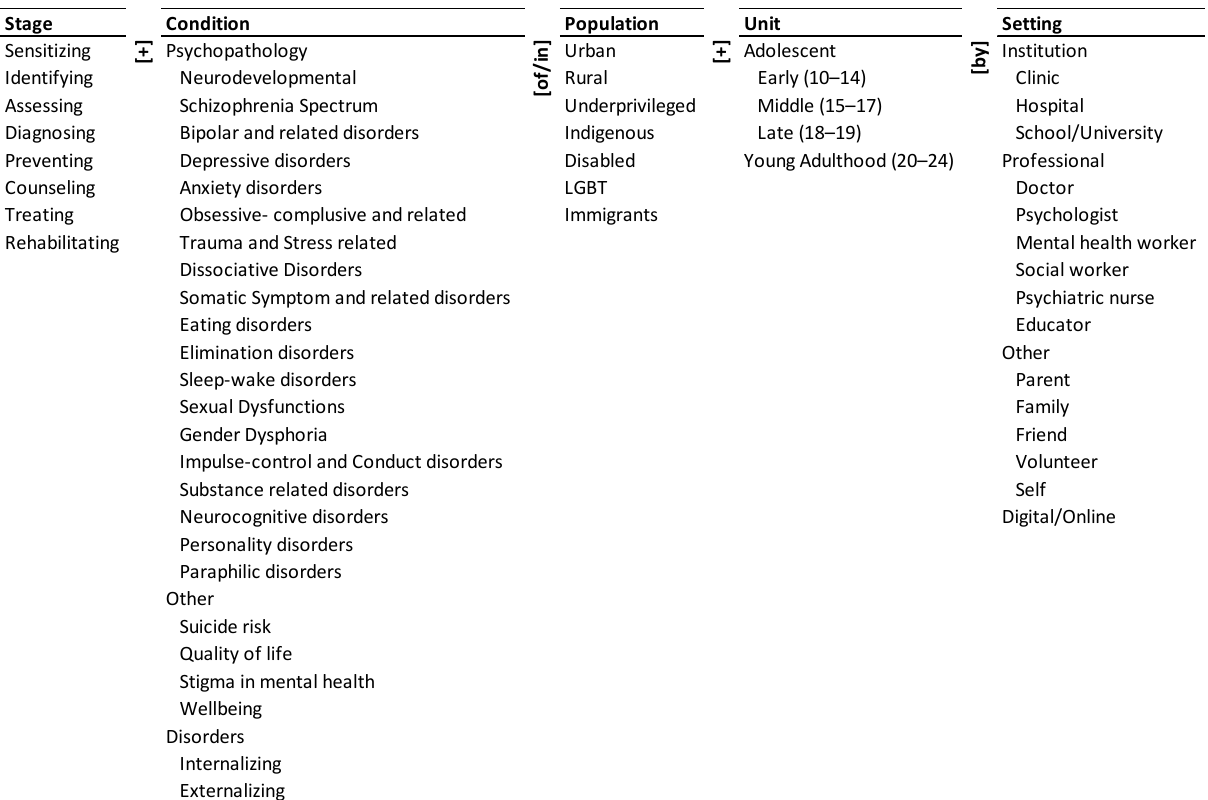
Figure 1. Ontology of mental health of adolescents and youth.